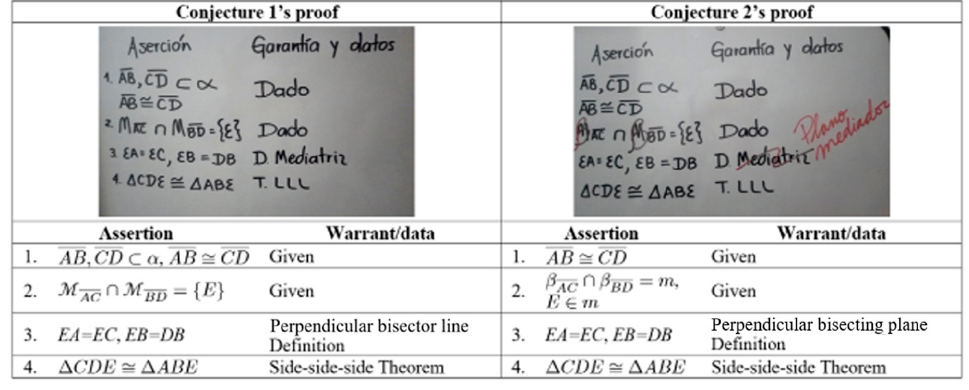
Figure 9. Transcription of the proofs for the conjectures.